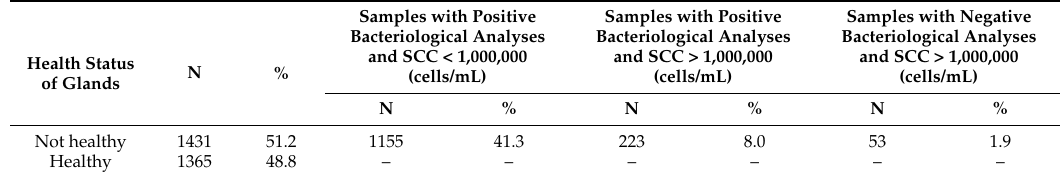
Table 6. Distribution of samples for each mammary gland health status considered.